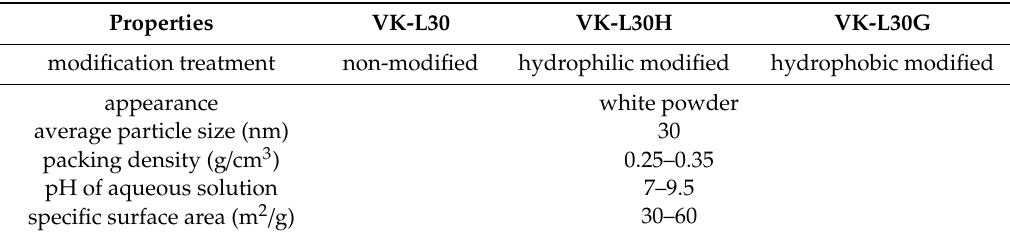
Table 1. Characteristic parameters of the experimental